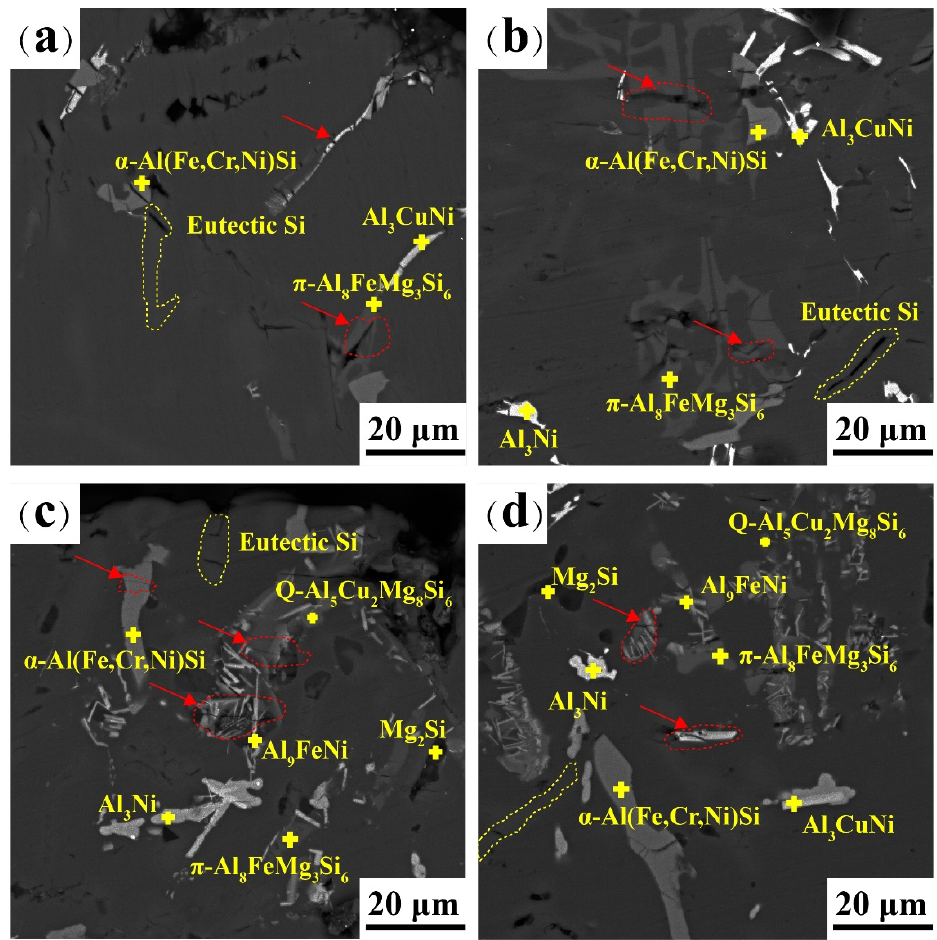
Figure 15. SEM images demonstrating the overall view of the polished cross-section of the tensile tested samples near the fracture surface of ( a ) as-cast alloy at 25 °C, ( b ) as-cast alloy at 350 °C, ( c ) T6 state alloy at 25 °C, ( d ) T6 state alloy at 350 °C.